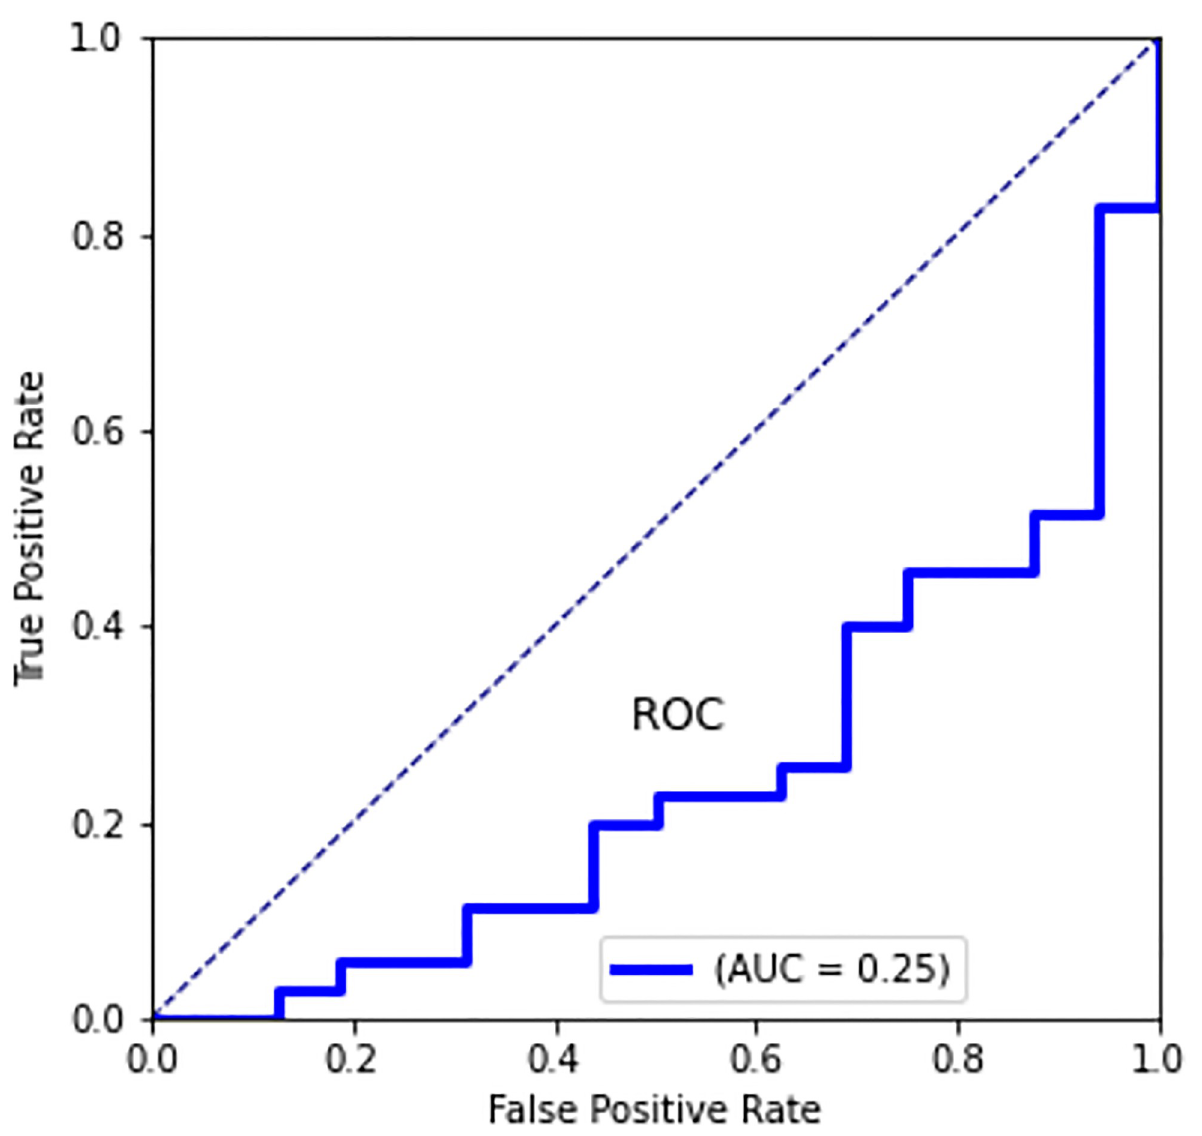
Fig 10. Quantification of anomaly via ROC curve and AUC index. A point on the ROC curve represents—for a certain threshold on the anomaly score—the FPR vs the TPR as defined in (6). We found AUC = 0.25, which means that a synthetic image is classified as synthetic in the 25% of cases and in the 75% is considered real. The dotted line represents the result one would obtain by tossing a coin to decide whether an image is artificial or